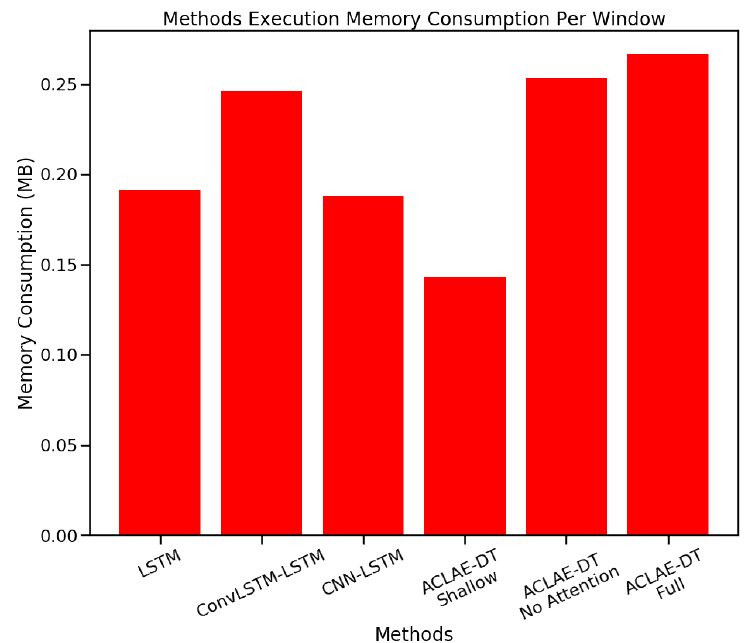
Figure 9. Execution memory consumption per